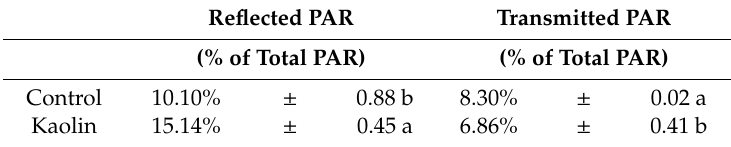
Table 1. Photosynthetically active radiation (PAR) reflected and transmitted at 1:00 p.m. by kaolin. Reflected